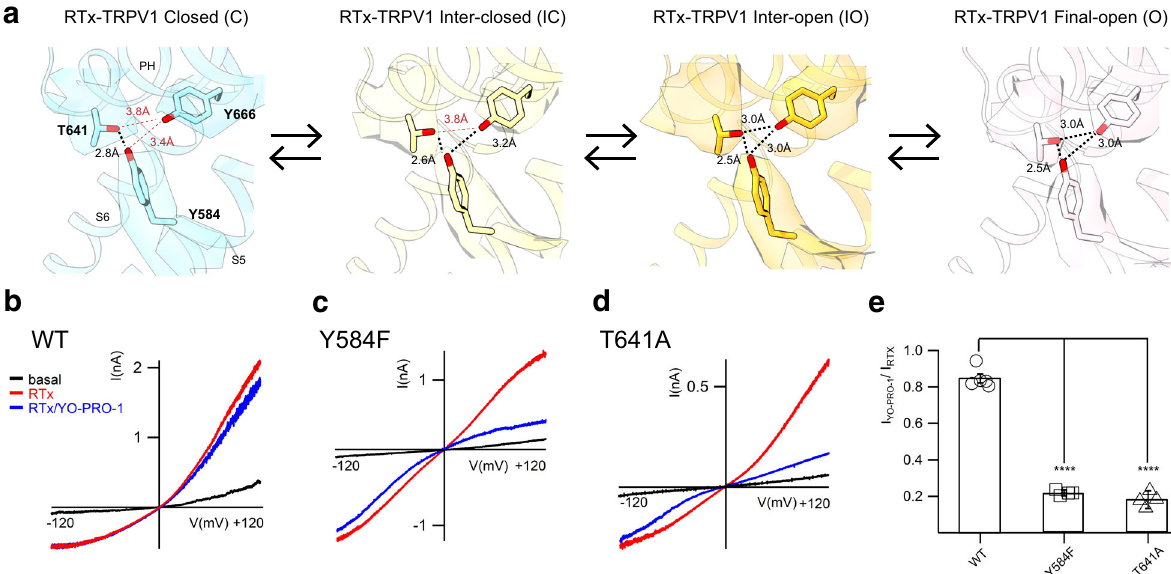
Fig. 6 PH-S5-S6 triad hydrogen bond network in TRPV1 for RTx gating. a The cryo-EM maps (surface) and respective models (sticks) depicting the tripartite hydrogen bond network of PH-S5-S6 in TRPV1 C, RTx (skyblue), thresholding 0.15, TRPV1 IC, RTx (yellow), thresholding 0.045, TRPV1 IO, RTx (gold), thresholding 0.1, and TRPV1 O, RTx (pink), thresholding 0.04. The black dotted-lines indicate hydrogen bonds. The red dotted-lines indicate distance measurements between atoms where hydrogen bonds are broken. b – e TRPV1 Y584F and T641A reduce large cation permeabilty (YO-PRO-1, M.W. 376 Da) in the presence of RTx. Representative inside-out current traces of TRPV1 WT b , TRPV1 Y584F c , and TRPV1 T641A d . Current traces for basal, RTx (200 nM) activation (red trace) and intracellular application of 10 μ M YO-PRO-1 (blue trace). e Summary of current inhibition by YO-PRO-1 (10 µ M) of TRPV1 WT, TRPV1 Y584F and TRPV1 T641A after application of a saturating concentration of RTx (200 nM). Data are presented as mean ± s.e.m.; P < 0.0001 for T641A and Y584F, two-tailed unpaired Student ’ s t test. (For WT, n = 5, for Y584F and T641A, n = 4). Source data are provided as a Source Data fi le.